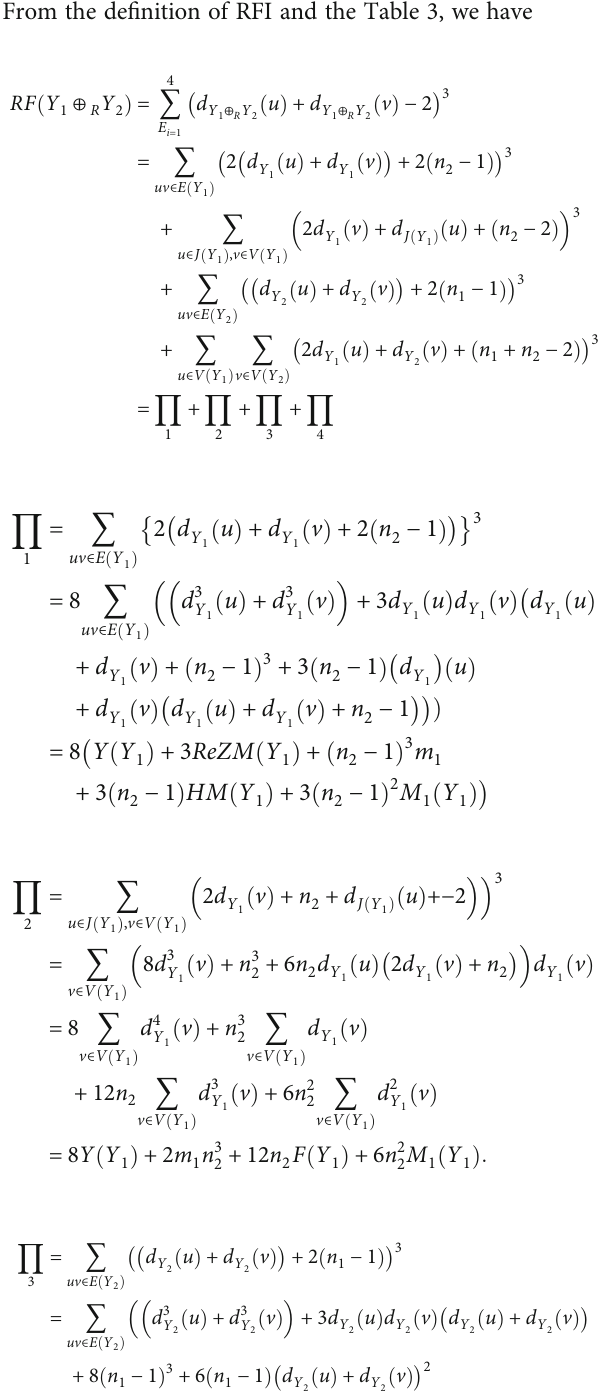
Table 2: The degree distribution of Y